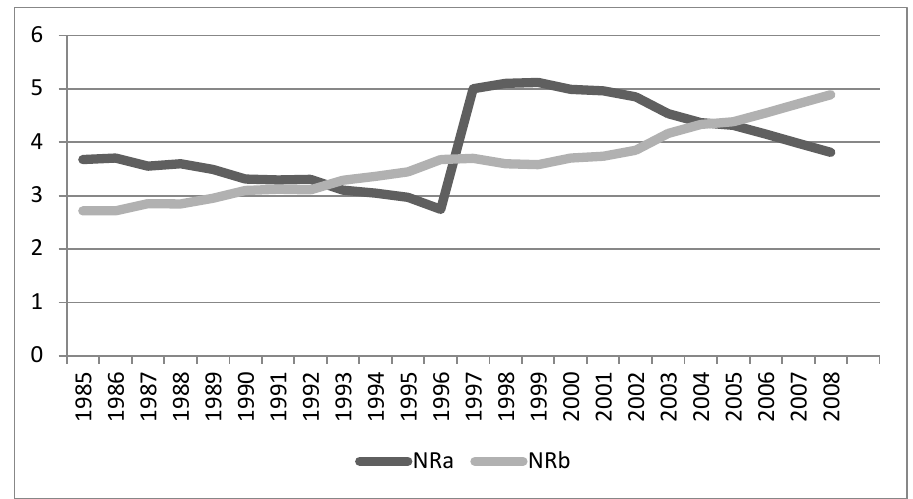
FIGURE 8: Plotting the resource conflict from 1985 to 2008, using 1985 as a base year and simulating a rainfall increase, as well as a policy shift of the ‘energy producer’ to alternative energy in 1997 Source: Author’s